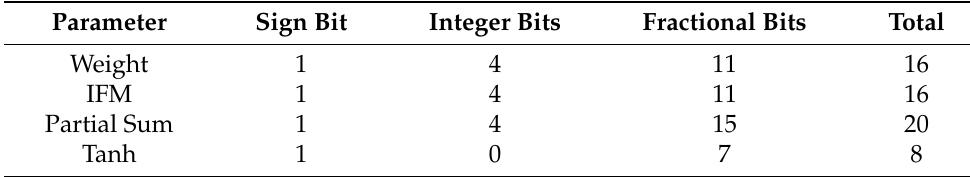
Table 7. Experimental results of fixed point